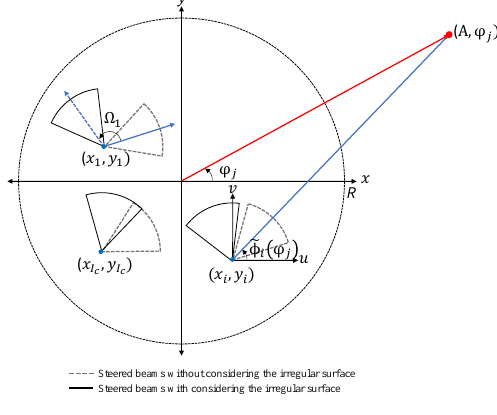
Figure 1. System